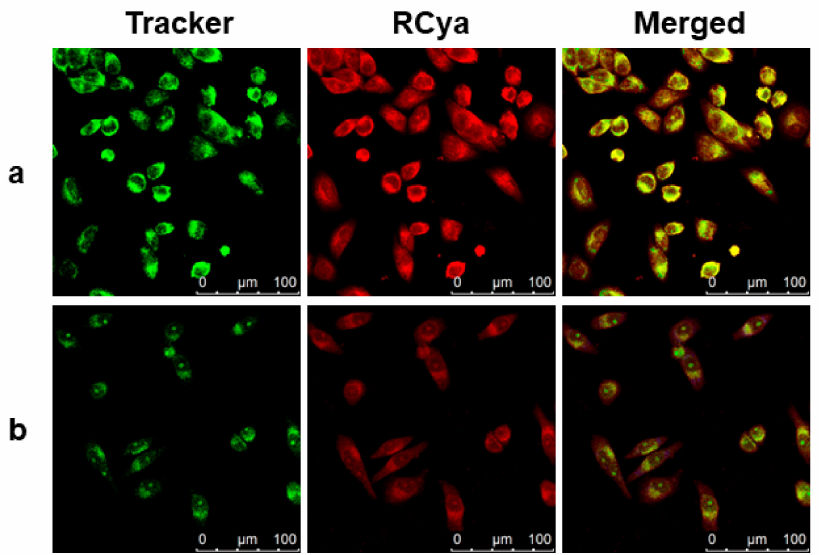
Figure 12. Con-staining fluorescence imaging of RCya + Pd 2+ and organelle-targeting trackers in HeLa: ( a ) the fluorescent image of HeLa costained with 1 µ mol L − 1 RCya, 1 µ mol L − 1 Pd 2+ and 100 nmol L − 1 Lyso-Tracker Green; ( b ) the fluorescent image of HeLa costained with 1 µ mol L − 1 RCya, 1 µ mol L − 1 Pd 2+ and 100 nmol L − 1 Mito-Tracker Green. Red channel: λ ex = 559 nm, λ em = 688–788 nm. Green channel: λ ex = 488 nm, λ em = 511–539